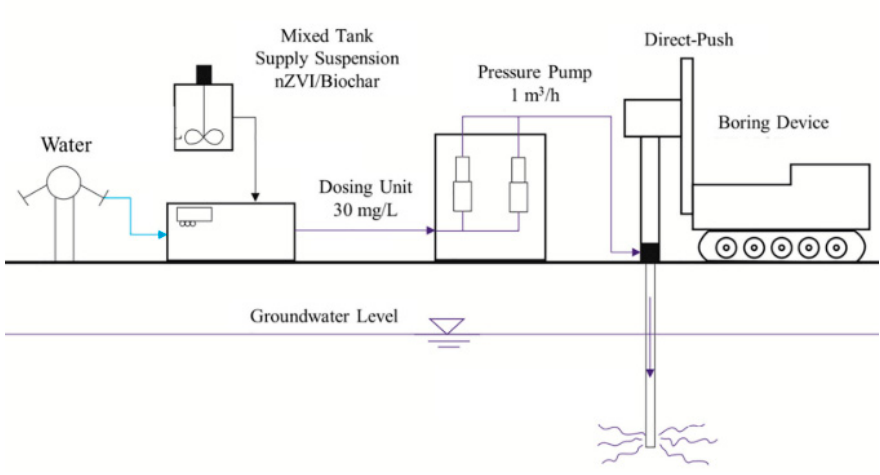
Figure 4. Step of injection procedure. Reprinted with permission from [112] (2020, Elsevier).